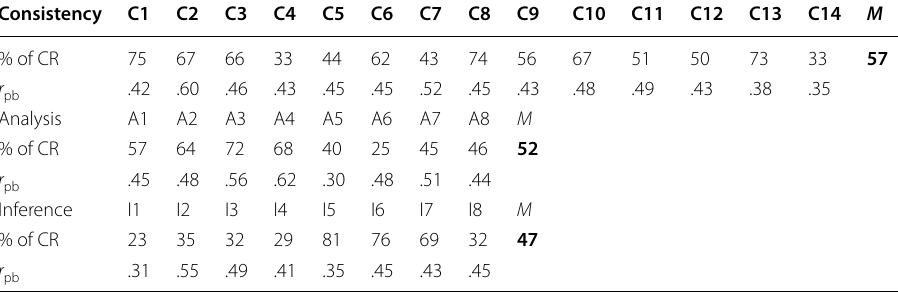
Table 3 Percentages of correct responses and point-biserial correlation coefficients of the three skills’ items